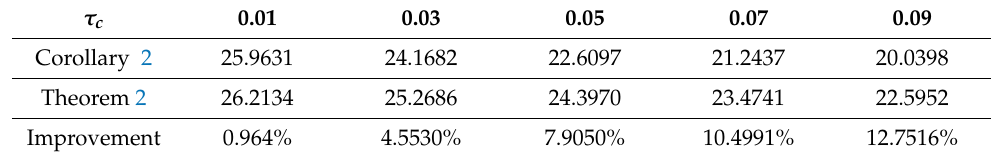
Table 2. The maximum sampling period d M with parameter uncertainties (Example